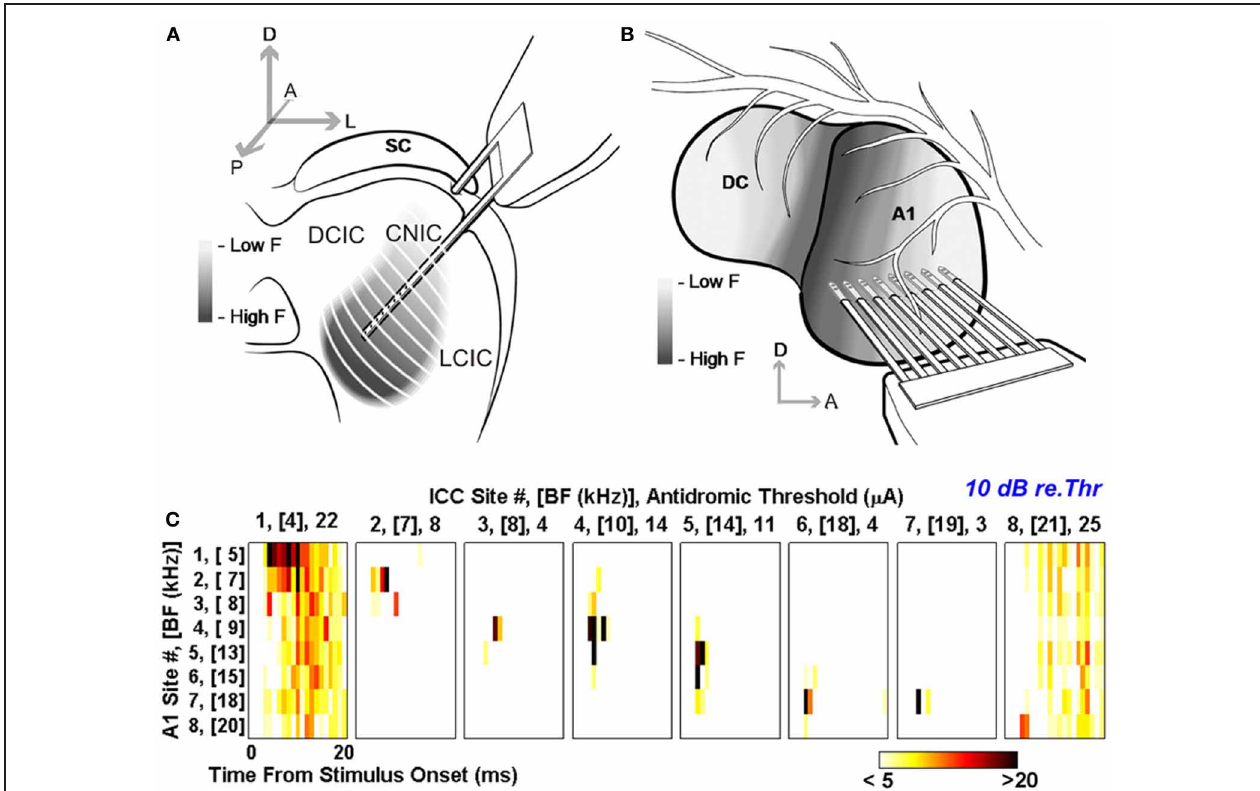
FIGURE 6 | Antidromic activation reveals tonotopically organized projections from A1 to the CNIC in guinea pig. Multi-site probes were positioned along the tonotopic axis of the guinea pig CNIC (A) and A1 (B) . (C) Post-stimulus time histograms (PSTHs) for eight A1 locations with different best frequencies (BF) from low (location 1) to high (location 8).